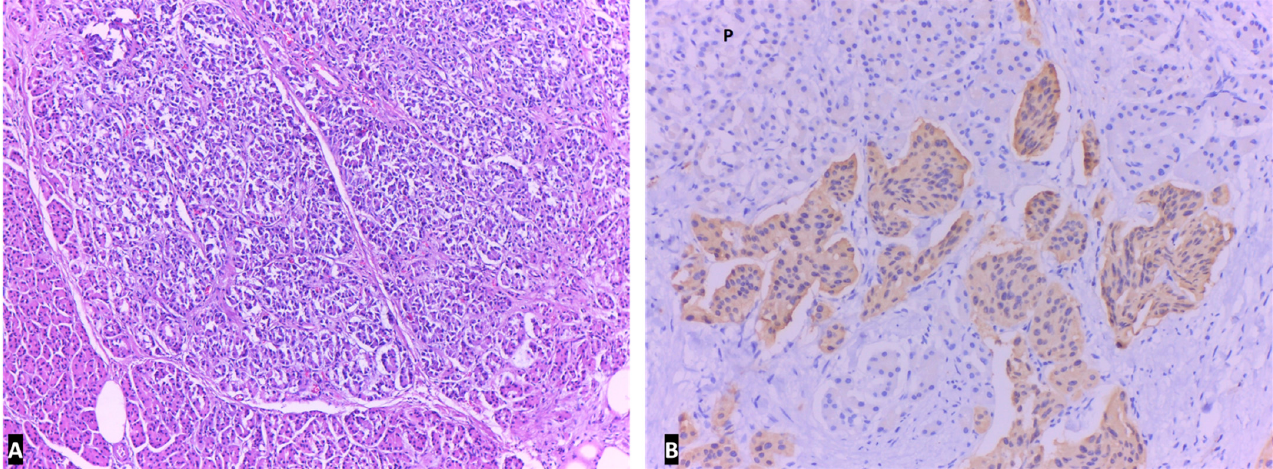
Figure 10. Lymph node metastasis of NEN, in Hematoxylin and eosin stain, ×40.